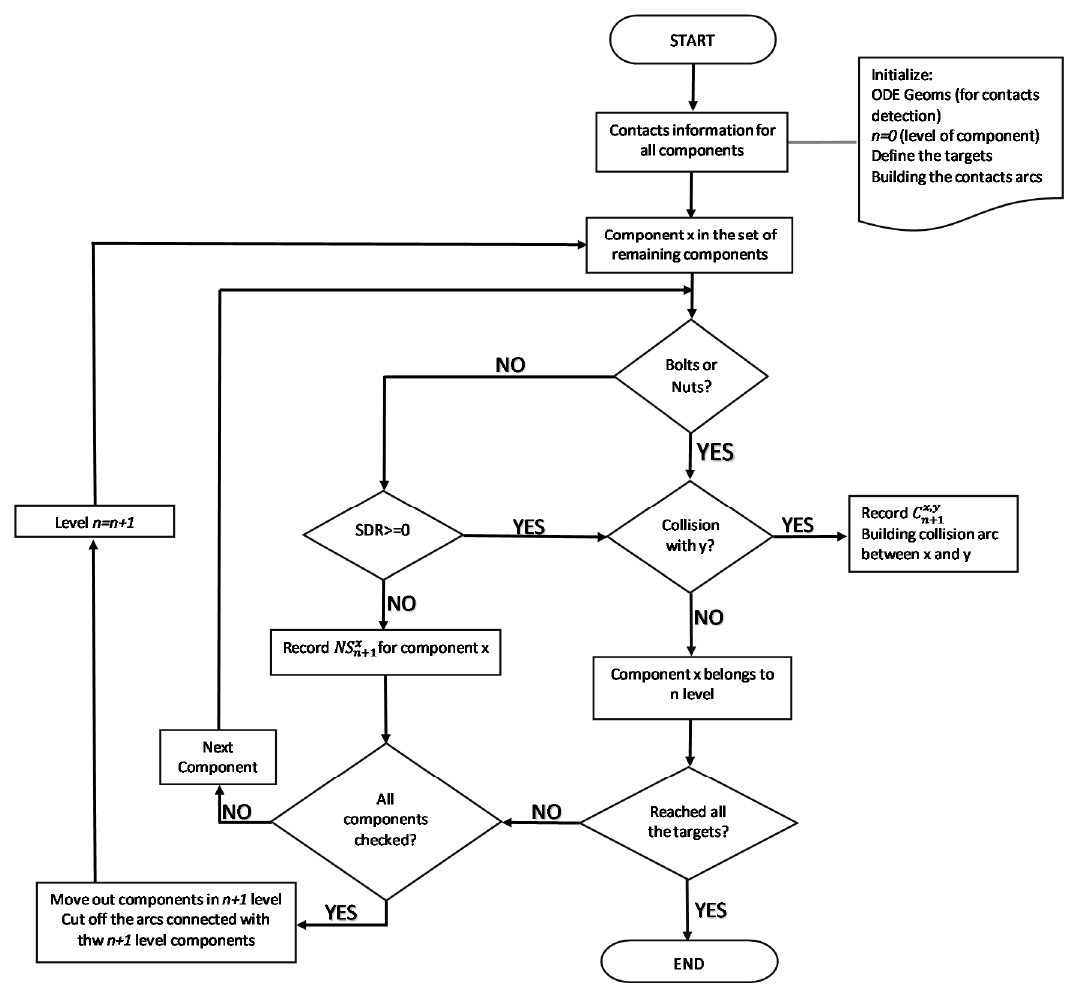
Figure 8. Diagram for generating geometric product disassembly chart (DGCG).